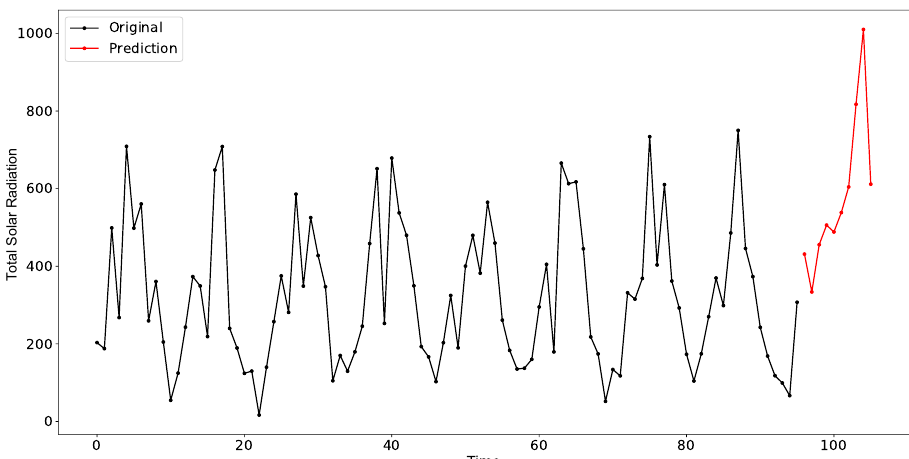
Figure 11. Result of dpsf_plot() for the “Total Solar Radiation”